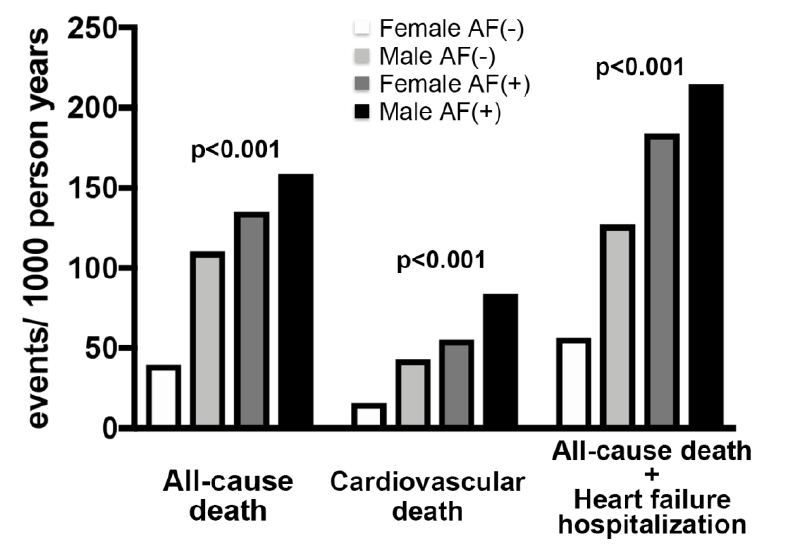
Figure 1. Crude numbers of adverse events following TAVI in the 4 study groups divided according to gender and preprocedural AF. The number per 1000 person years of all-cause and cardiovascular mortalities, and the composite of all-cause death and heart failure hospitalization after TAVI were significantly different among the groups. The order of all events was identical; from the lowest to the highest; Female AF(-), Male AF(-), Female AF(+) and Male AF(+).